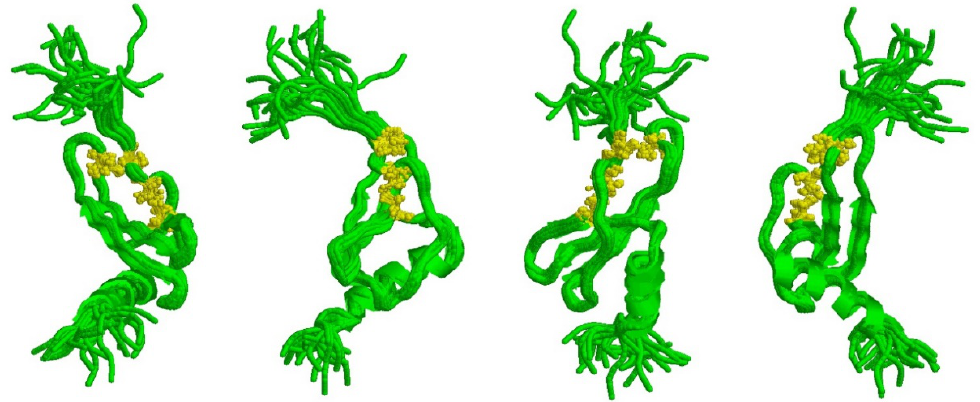
Figure 3. Structure of CXCL1 . The tertiary structure of CXCL1 with the two disulfide bridges is highlighted in yellow. The N -terminal structure of CXCL1 is not stabilized; therefore, the figure shows many different possible conformations of this, as well as the other terminus of the CXCL1 chain. The graphic was created using RasMol 2.7.4.2 [136,137], and the CXCL1 structure was deposited in the Protein Data Bank (PDB) [138] under the identifier 1MGS [133,134].